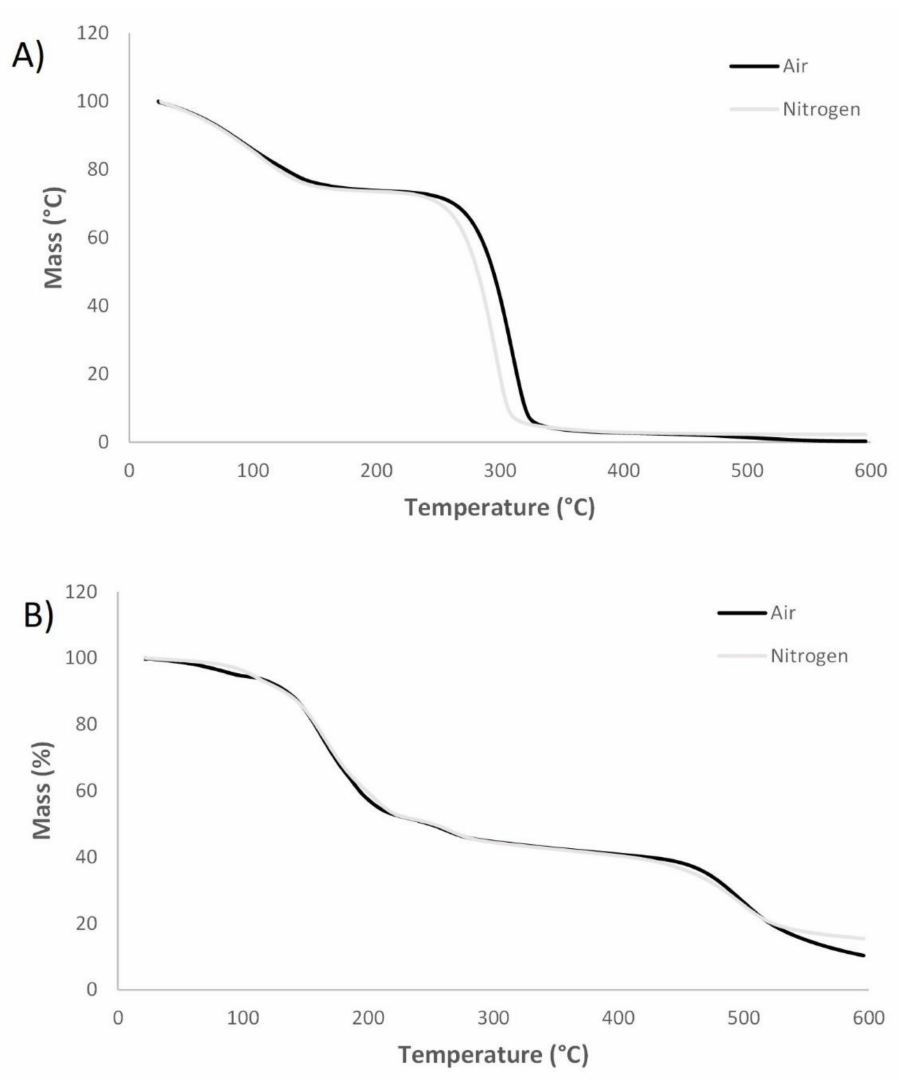
Figure 4. TGA curves from unmodified sorbitol in air and nitrogen ( A ) and modified sorbitol in air and nitrogen ( B